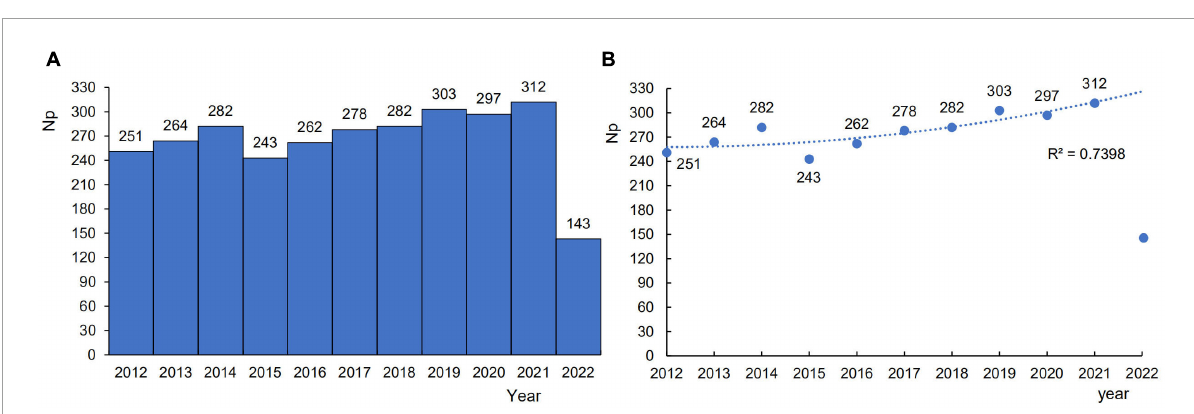
FIGURE2 The global trends in publications on Helicobacter pylori -related gastric ulcer (GU). (A) An overview of global publications growth between 2012 and 2022 is shown in the histogram. (B) The curve shows the fit of the model to growth trends in